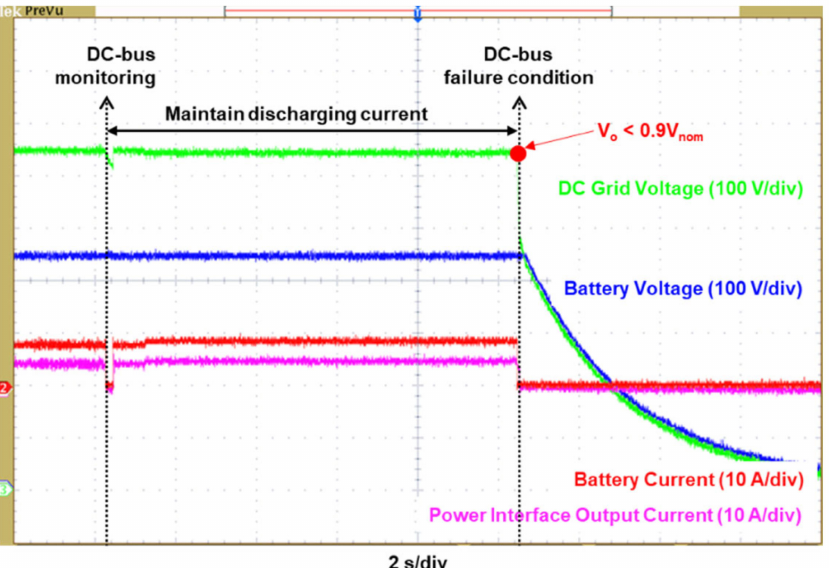
Figure 19. Fault response of proposed voltage regulation algorithm in charging sequence.